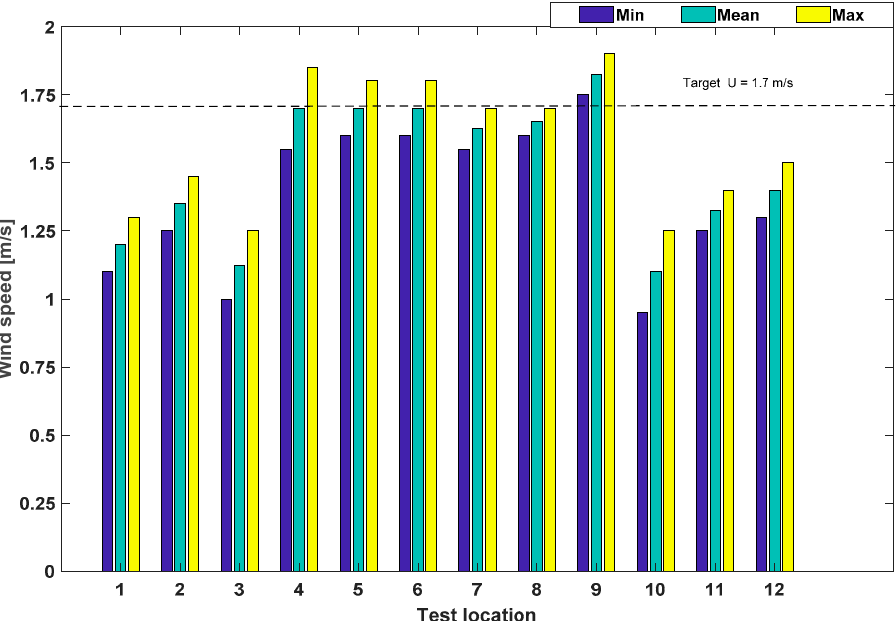
Figure 7. Recorded wind speeds for each test location.